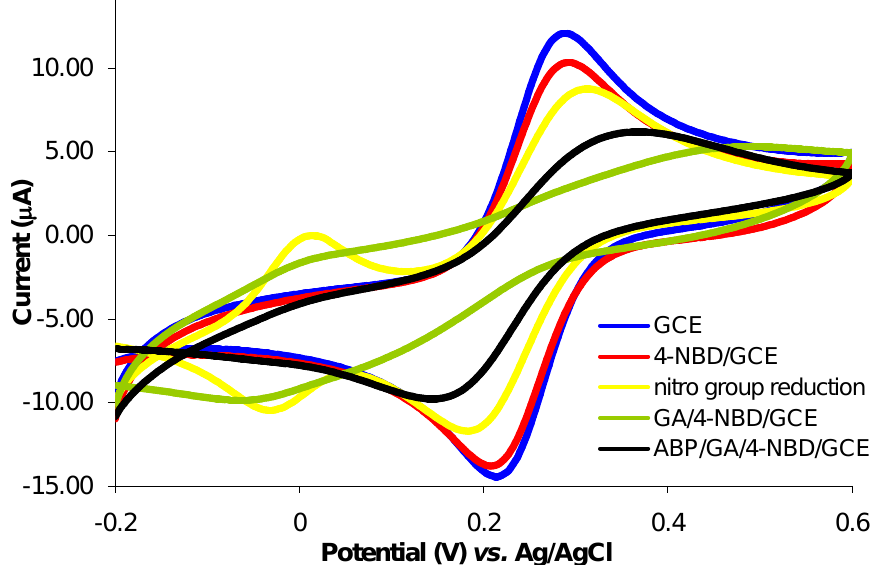
Figure 1. The cyclic voltammograms of 1 mM Fe(CN) 63− in PBS (pH 7, 0.1 M KCl) on a polished GCE (─); 4-NBD/GCE (─); after reduction of nitro groups to amino (─); GA/4-NBD/GCE (─); ABP/GA/4-NBD/GCE